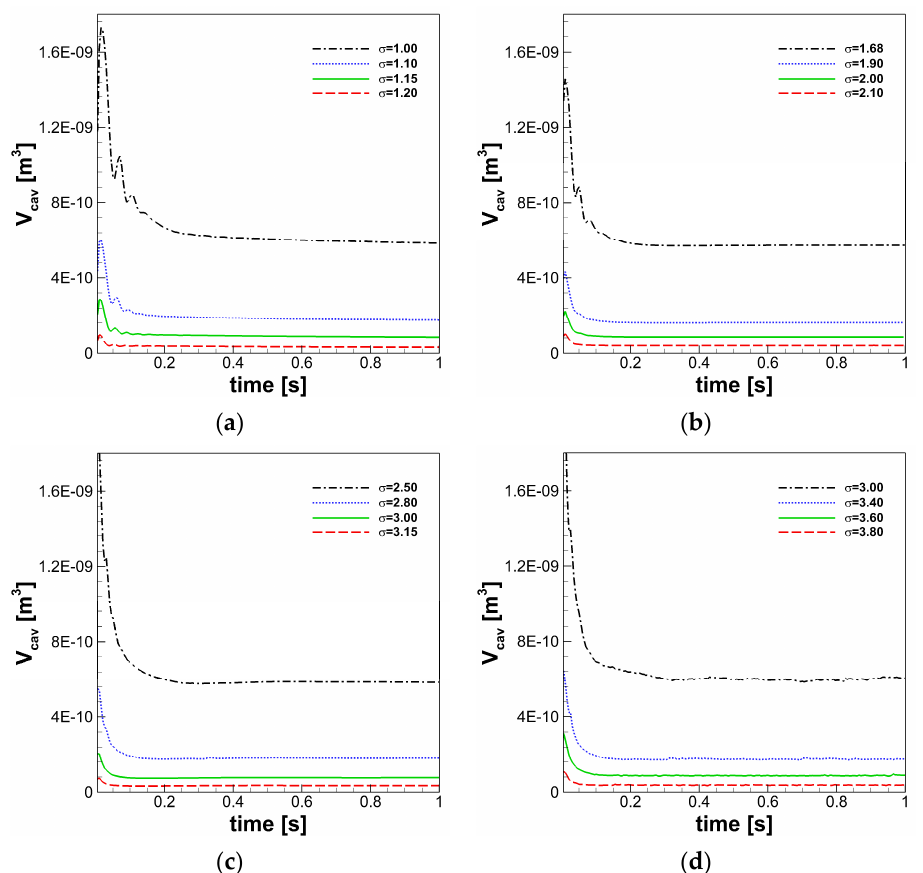
Figure 16. Time histories of the cavitation volume at different Reynolds numbers: ( a ) R e = 5.0 × 10 4 ; ( b ) R e = 1.0 × 10 5 ; ( c ) R e = 3.0 × 10 5 ; ( d ) R e = 1.0 × 10 6